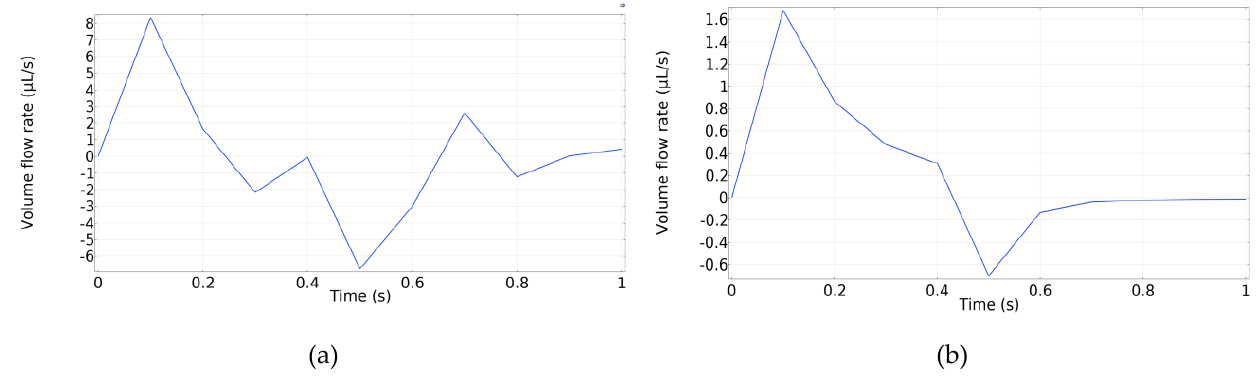
Figure 13. Volume flow rate. ( a ) Without valves. ( b ) With duckbill valves. The displacement and velocity field history of the micropump is shown in Figure 14a–f for the contraction phase, i.e., t = 0–0.5 s. One can see that the right duckbill deforms and propels the fluid, whereas the left duckbill valve closes and blocks the backflow. Figure 14a shows the flow field at the beginning of the simulation at t = 0 s. In Figure 14b, the MRE is started deforming downward, pushing the fluid toward the right terminal. Due to a large amount of fluid being enclosed in between the two valves, the fluid shows maximum velocity at the right valve in this stage. In Figure 14c, the upper wall deforms further, and thus, the right duckbill bends, but this time the tips of the right valve come closer to each other, thus decreasing fluid displacement ( t = 0.2 s). In Figure 14d, the right duckbill valve deflects further and reduces the fluid flow, and the left valve closes completely to prevent the backward flow ( t = 0.3 s). In Figure 14e, deformation of the upper wall and duckbill valves continue ( t = 0.4 s). In Figure 14f, the deflections on the upper wall ( t = 0.5 s). At this time, the micropump is about to start the expansion phase.